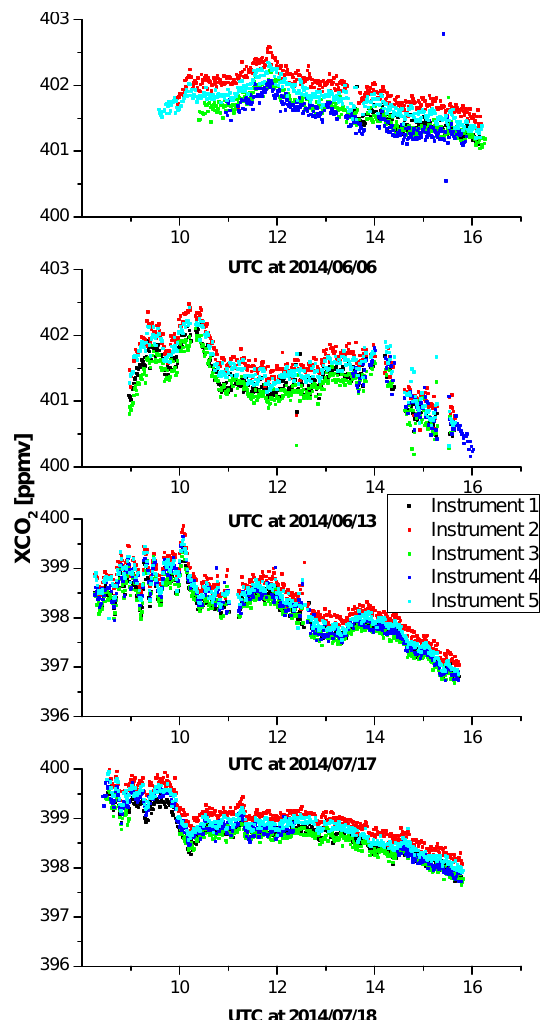
Figure 8. Calibrated XCH 4 values for all instruments. Experiments and measurement days are the same as for O 2